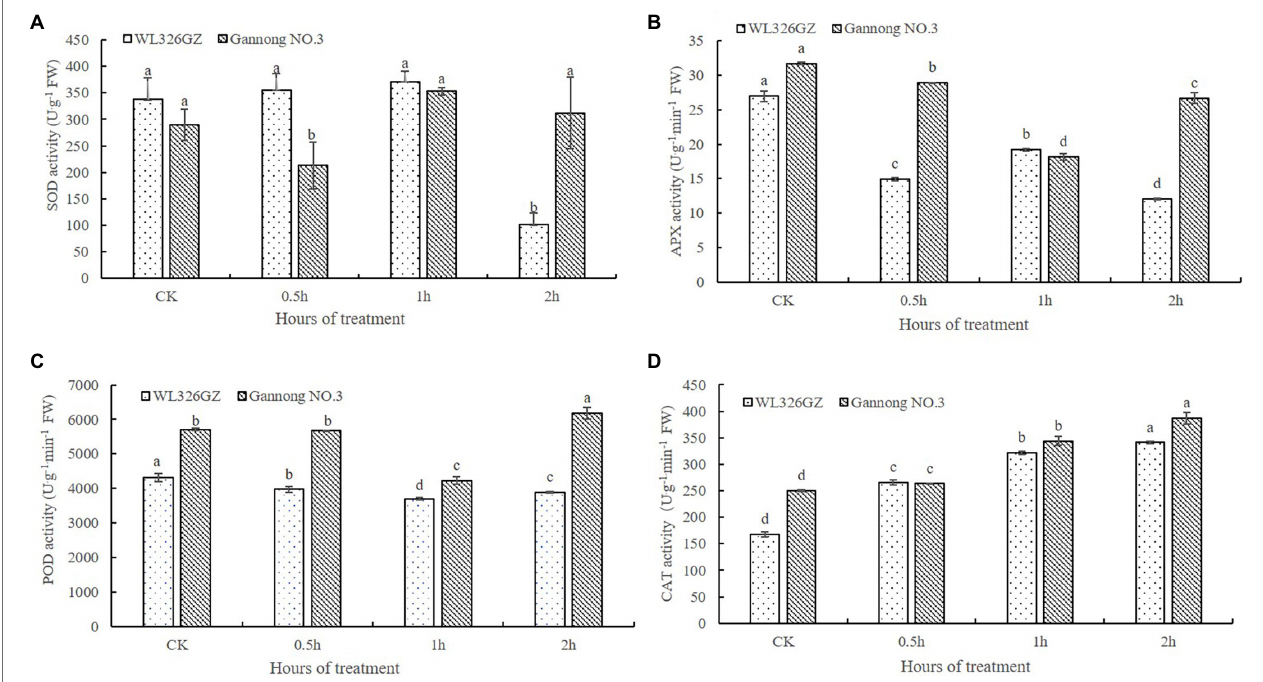
FIGURE 2 | Effect of freezing stress on the activities of SOD (A) , APX (B) , POD (C) , and CAT (D) in leaves of two types of alfalfa. The data represents mean ± SD ( n = 3), and the different letters above the bar represents the values were significant difference in “WL326GZ” or “Gannong NO.3” with different freezing treatment ( p < 0.05, Duncan’s test).